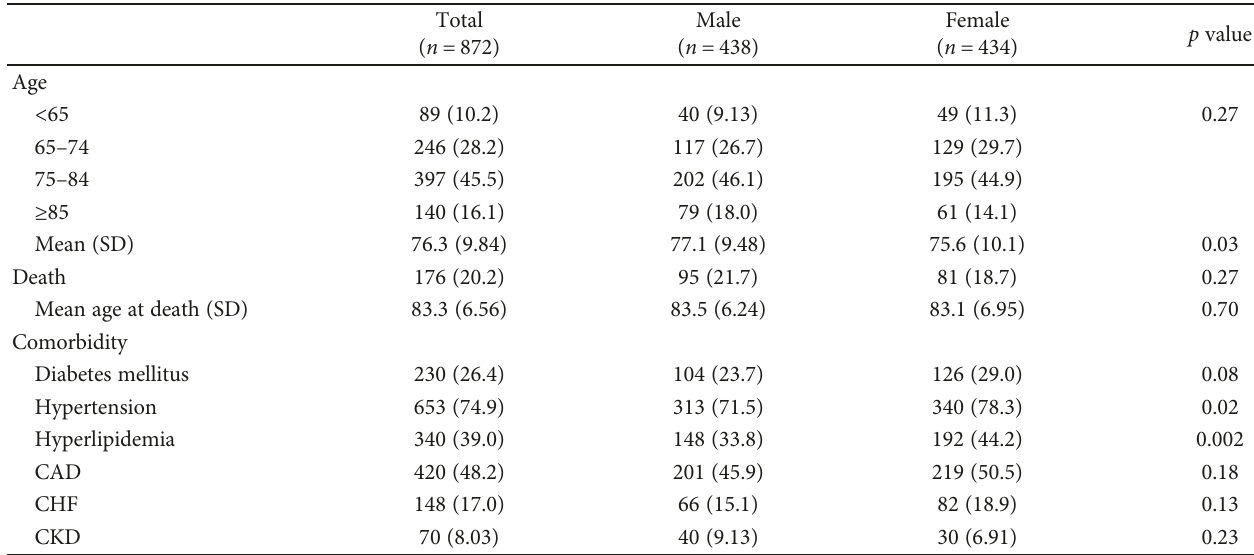
Figure 1: Flowchart of DLB patient selection from the National Health Insurance Research Database in Taiwan. Table 1: Characteristics of